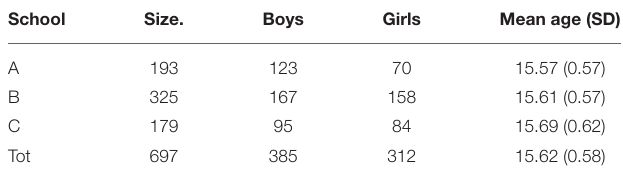
TABLE 1 | Demographic information of the